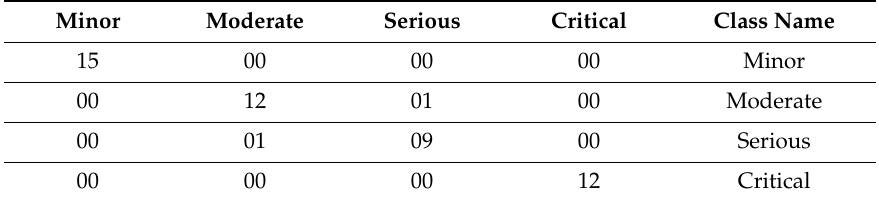
Table 11. Confusion Matrix for fold 4.